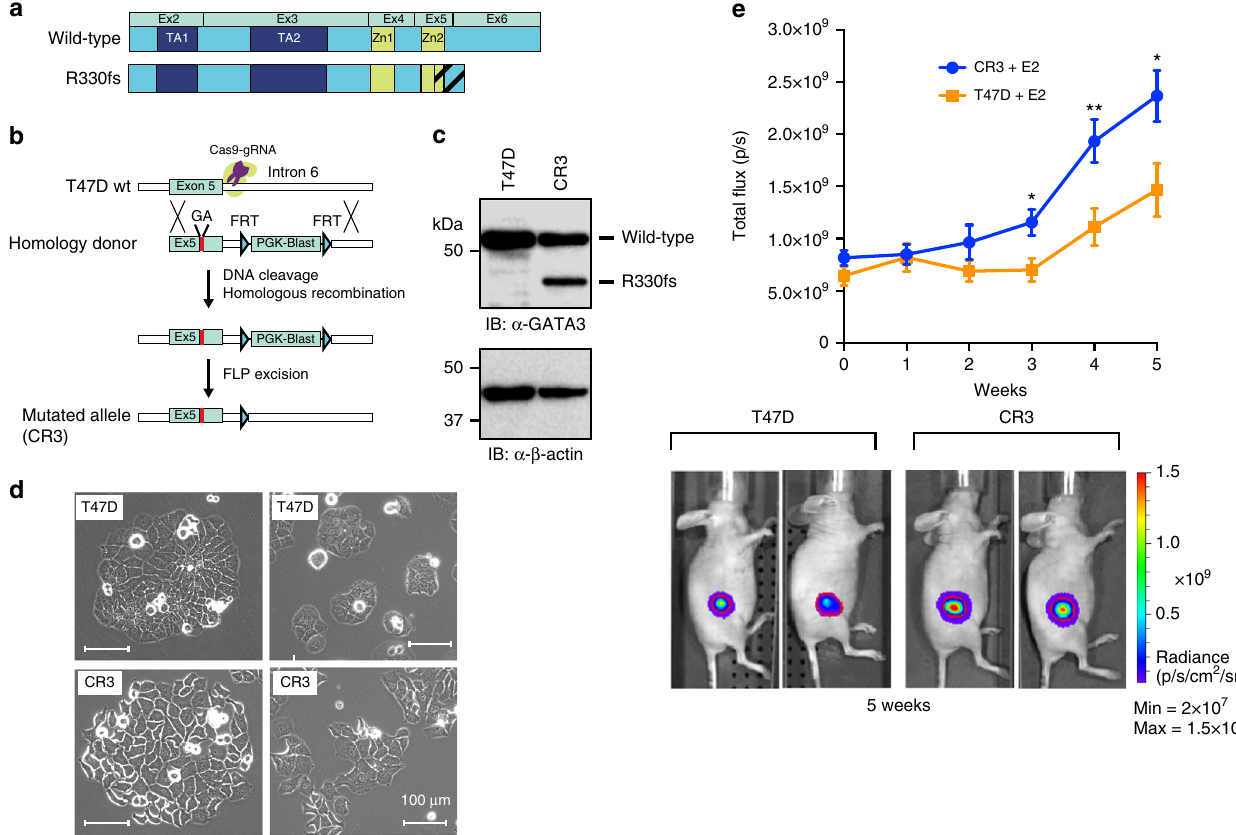
Fig. 2 GATA3 R330fs mutation facilitates tumor proliferation. a The protein domain structures of wild-type GATA3 and R330fs mutant are indicated. b Schematic diagram of genome editing by the CRISPR – Cas9 method. c Immunoblot analysis of the R330fs mutant clone (CR3). d Representative images of control T47D and CR3 cells. The scale bar indicates 100 μ m. e Tumor growth in the mouse xenograft model. The average bioluminescence signals are quanti fi ed and plotted with SEM as error bars ( N > 12). E2: estradiol pellet. Representative images are shown at the bottom. The red outline over tumors encompasses 97% of total bioluminescent signal in each animal. * p < 0.05, ** p < 0.01, unpaired t